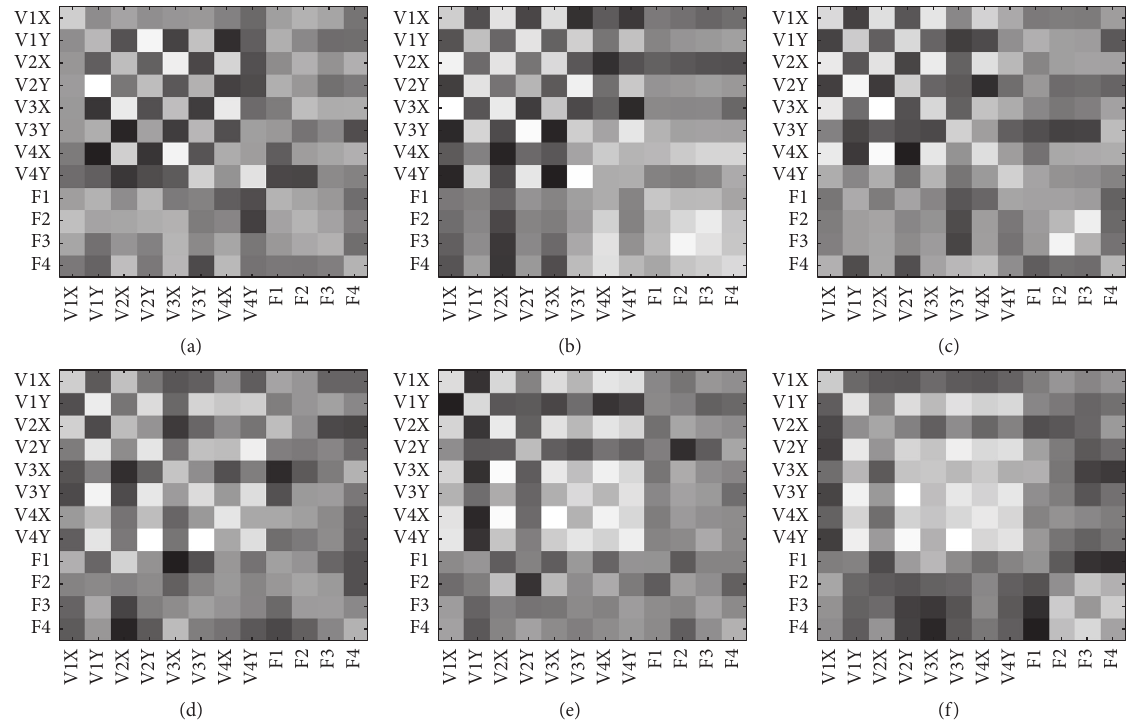
Figure 7: Correlation coefficient matrices under different fault conditions. (a) IB. (b) MA. (c) BSL. (d) RI. (e) CFRM. (f) CFBM.